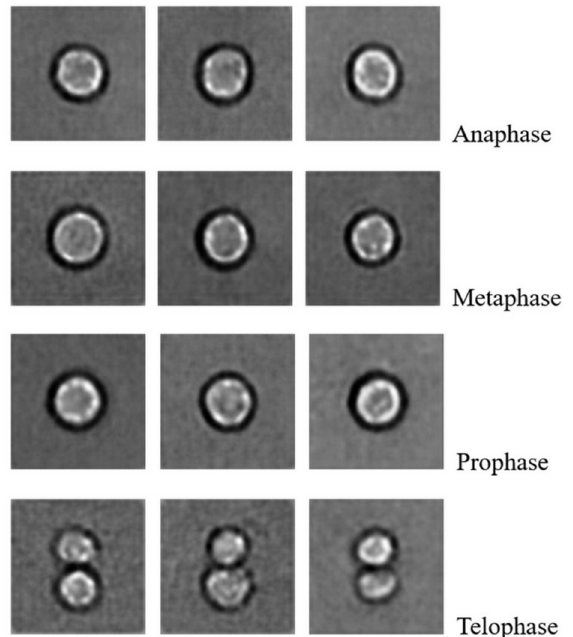
Figure 5. The generated images of different cell cycle stages.